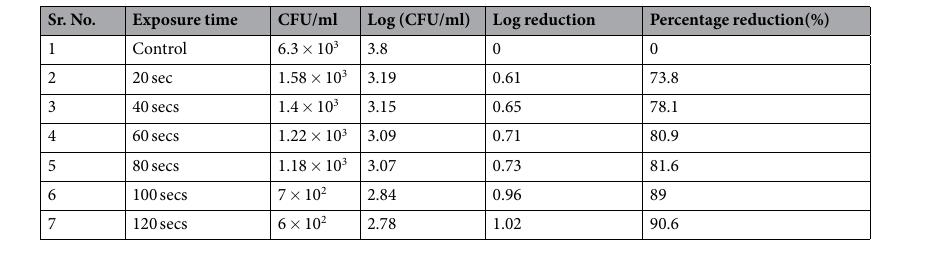
Table 2. Effects of Xe 2 * dimer on E . coli bacterial deactivation.